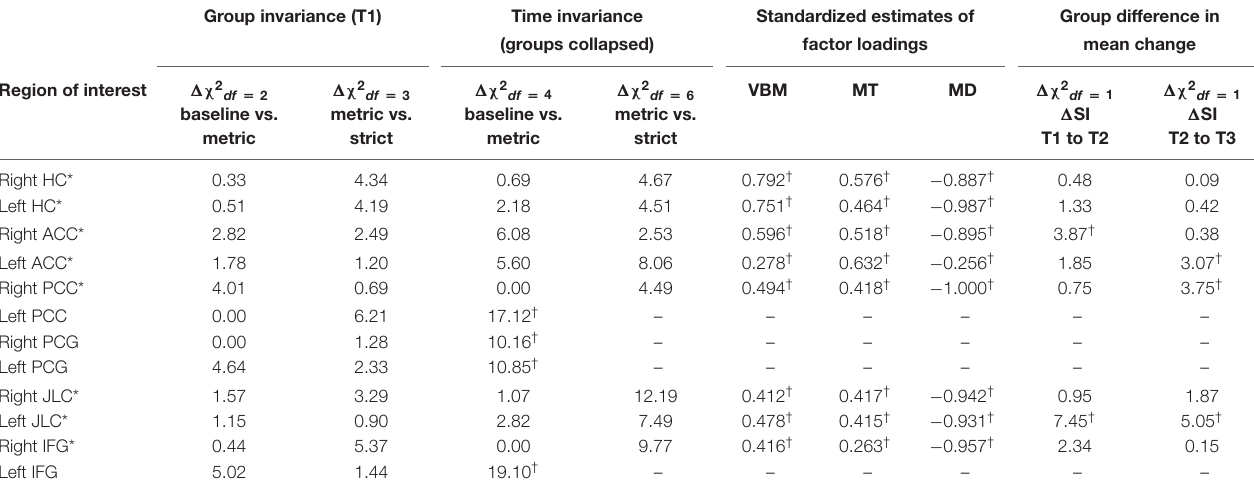
TABLE 2 | Testing for invariance across groups and time points, and testing for equal vs. unequal mean change parameters across groups. Group invariance (T1) Time invariance Standardized estimates of Group difference in (groups collapsed) factor loadings mean